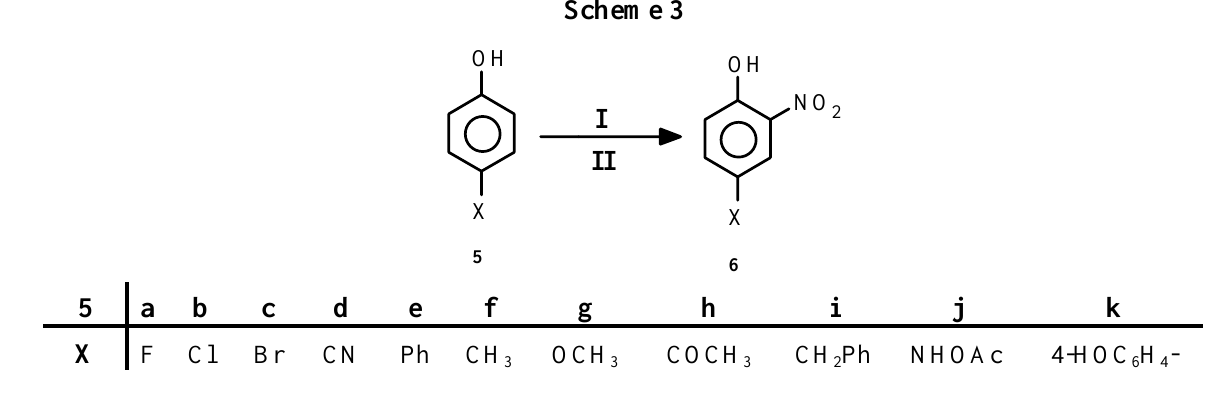
Table 1. Mononitration of Phenols to Their Corresponding Nitro derivatives with a Combination with Silica Sulfuric acid (I), NaNO Dichloromethane at Room